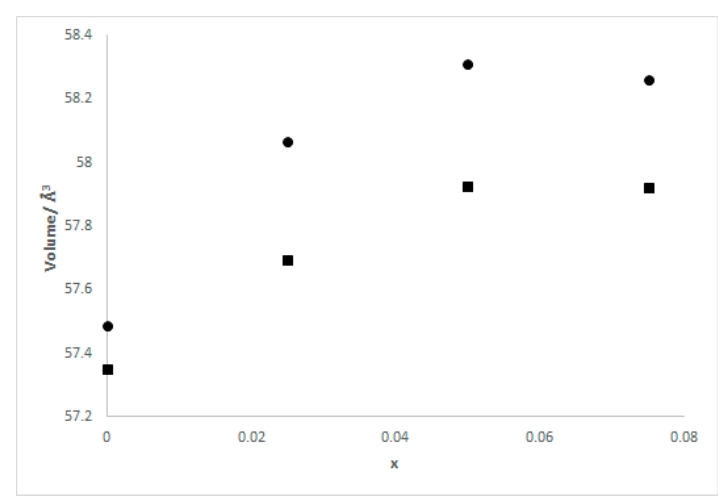
Figure 8. Plot of unit cell volume vs. x for SrFe 1 − x S x O 3- δ heated in air ( ● ) and heated in O 2 ( ■ ).